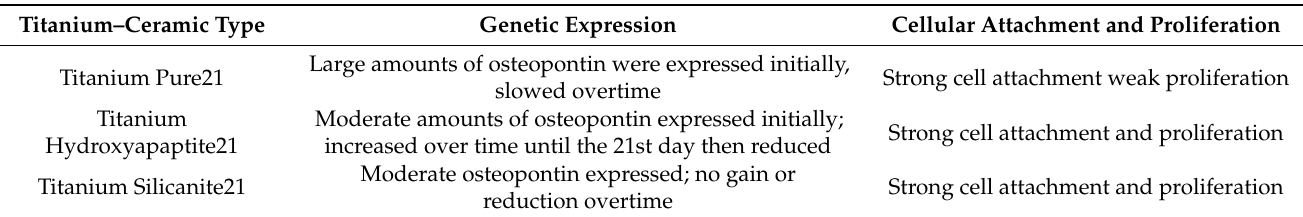
Table 7. Various titanium–ceramic implants and their in vitro analysis. Titanium–Ceramic Type Genetic Expression Cellular Attachment and Proliferation slowed